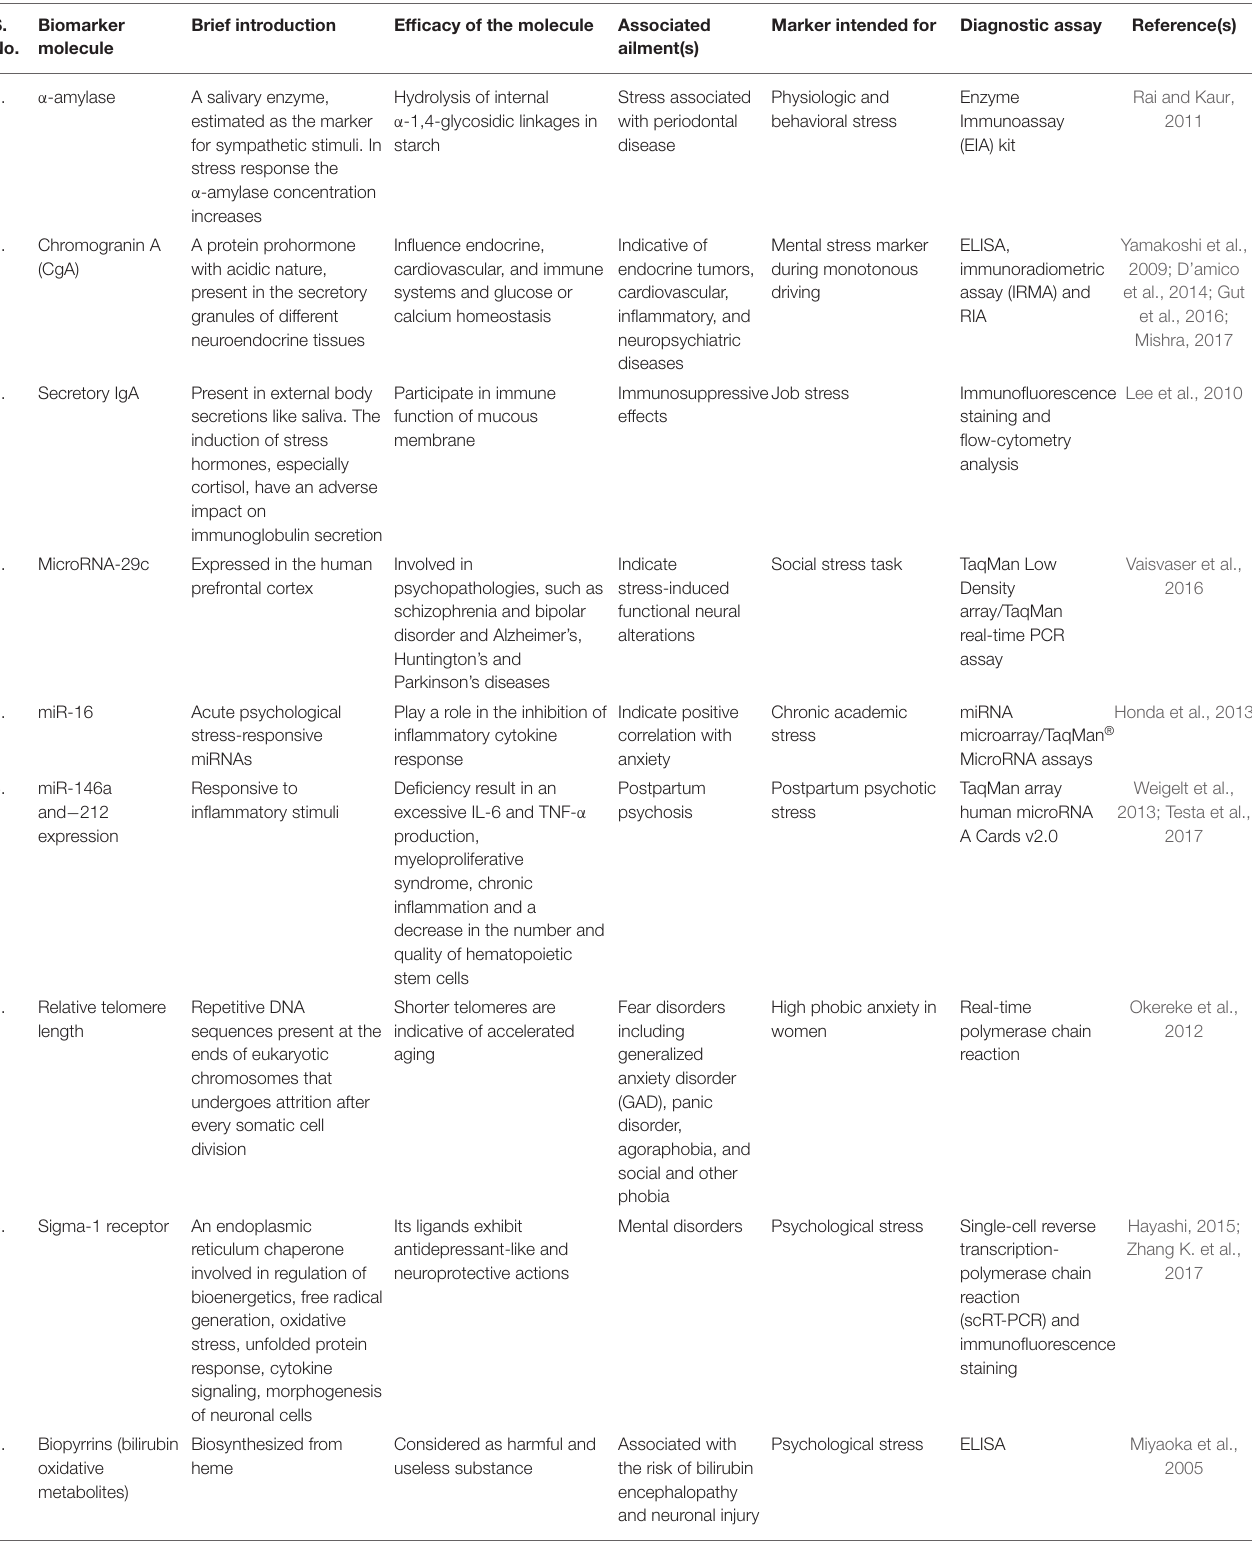
TABLE 4 | Various biological markers associated with numerous physical, emotional and environmental